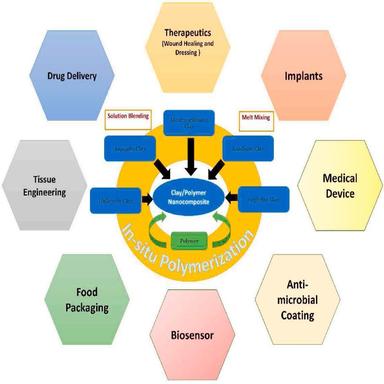
Multifunctional biomedical application of nano-clay composites.